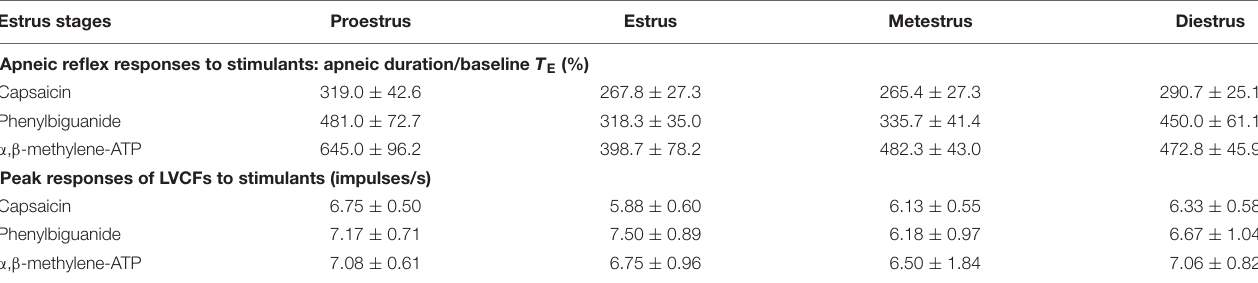
Estrus stages Proestrus Estrus Metestrus